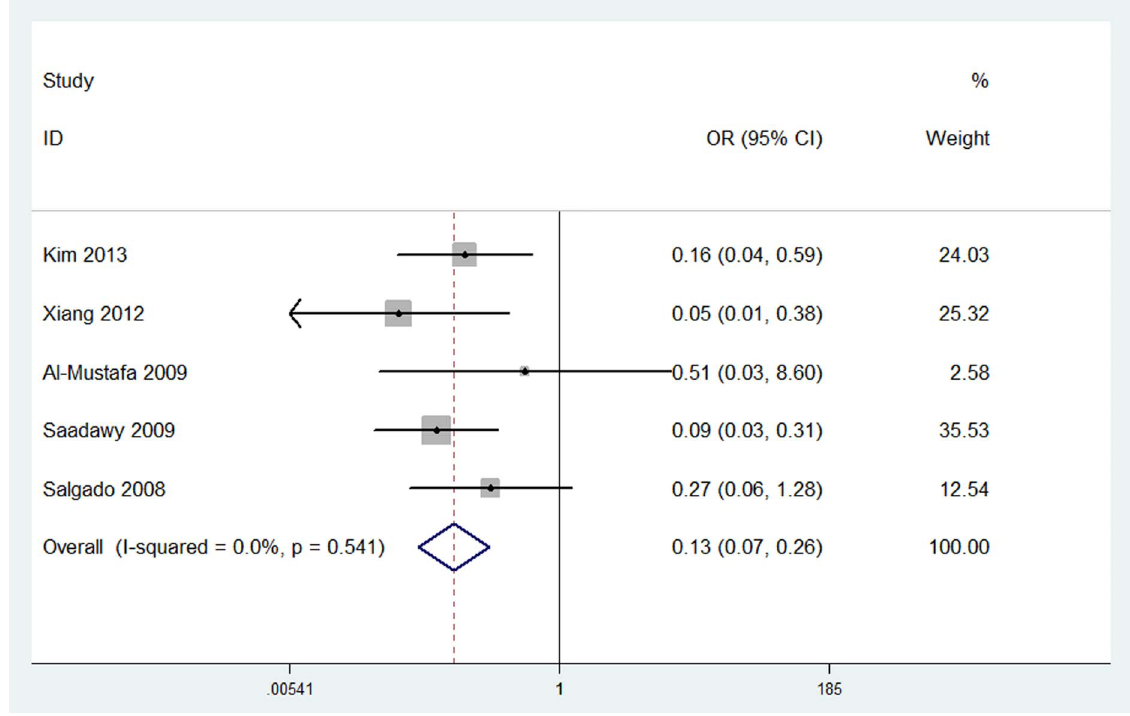
Figure 5. Forest plot: The number of postoperative analgesic requirements.